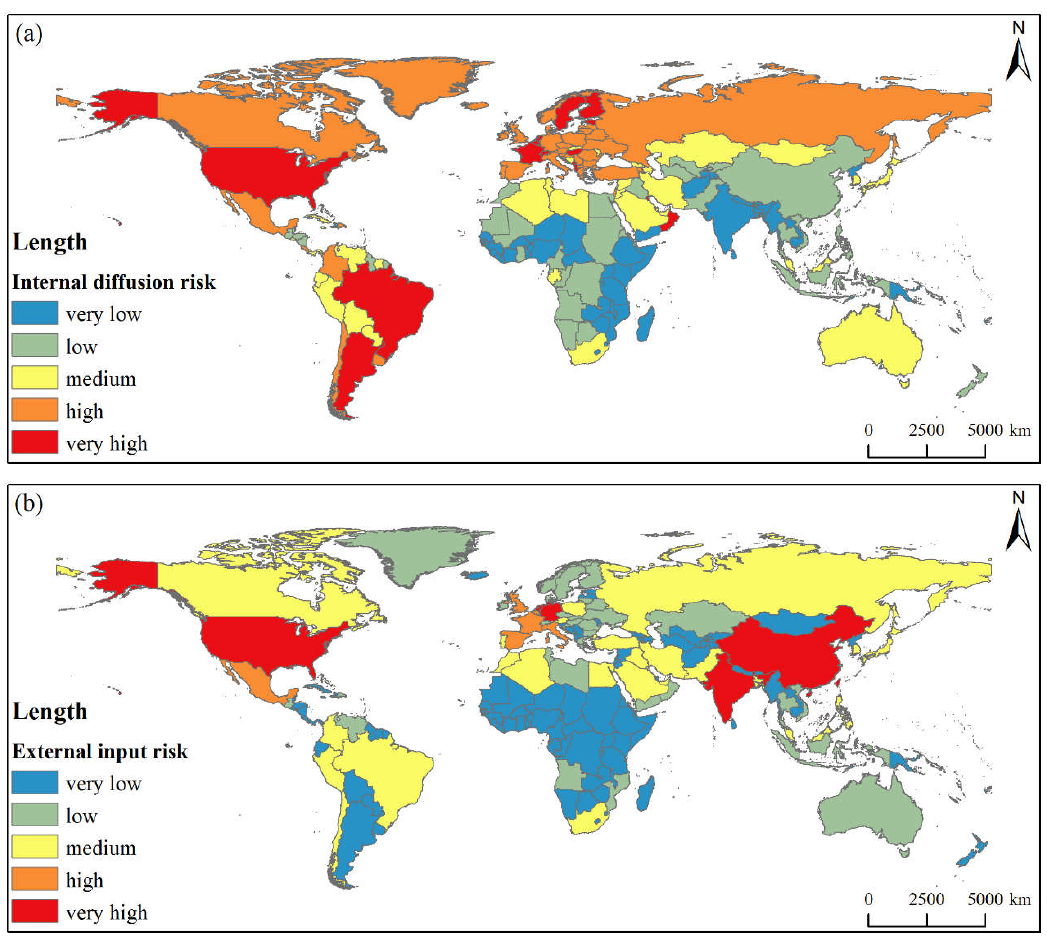
Figure 6. Spatial pattern of internal diffusion risk ( a ) and external input risk ( b ). Table 5. Classification statistics of different COVID-19 transmission